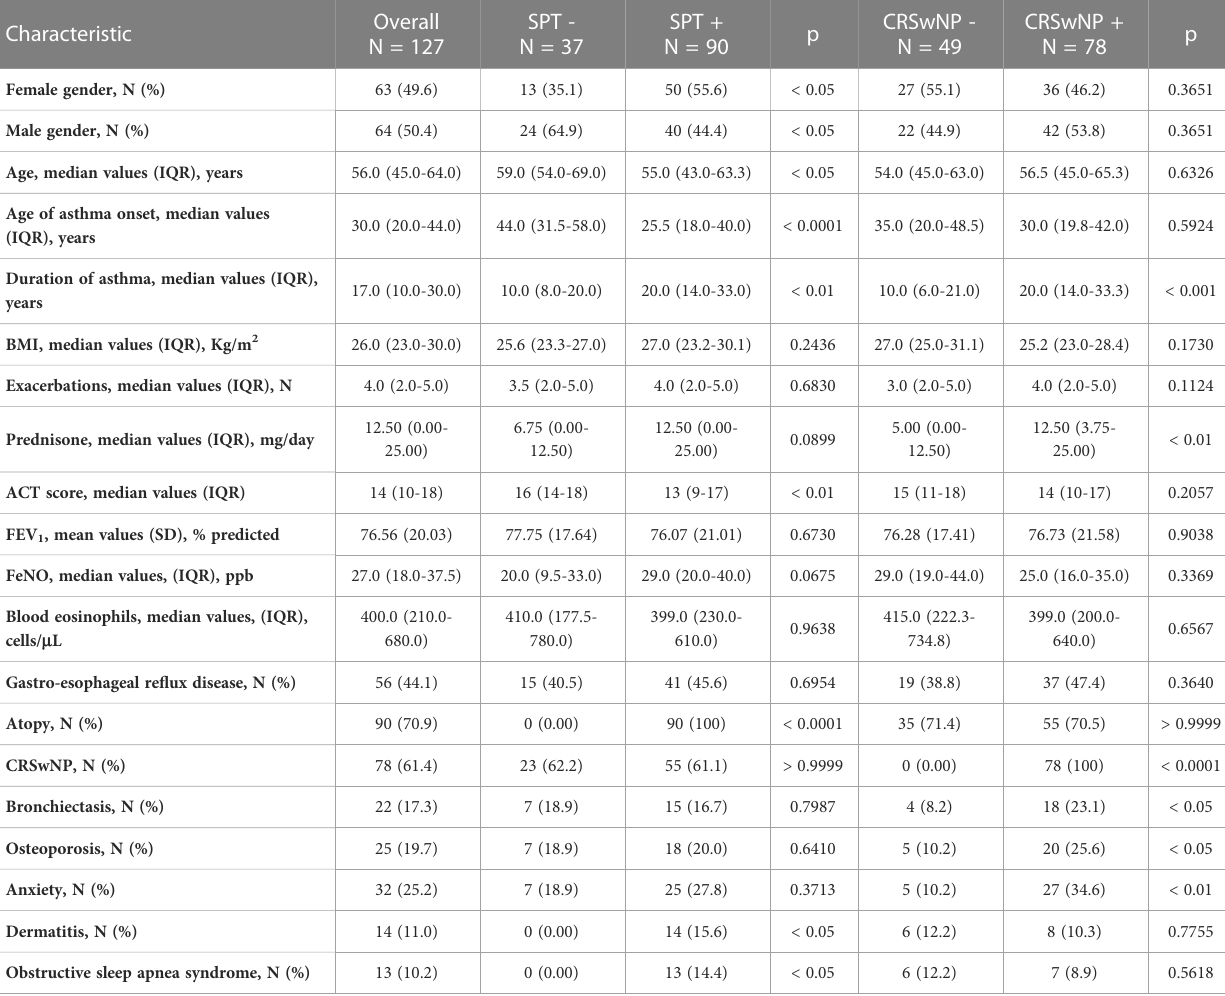
SPT, skin prick test; CRSwNP, chronic rhinosinusitis with nasal polyps; IQR, interquartile range; SD, standard deviation; BMI, body mass index; ACT, asthma control test; FEV1, forced expiratory volume in one second; FeNO, fractional exhaled nitric